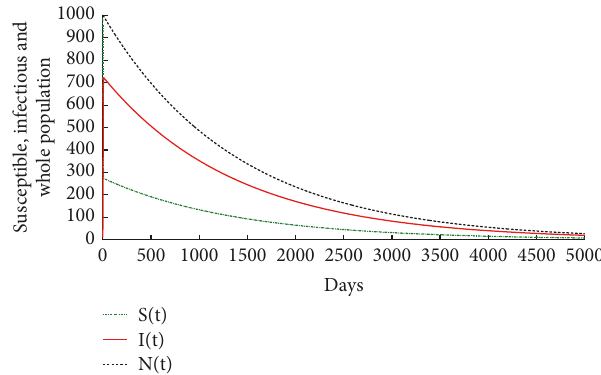
Figure 2: Susceptible, infectious, and whole population in the SISV model without vaccination when the basic reproduction number of its corresponding normalized SISV model is 𝑅 0 = 3.6438 .